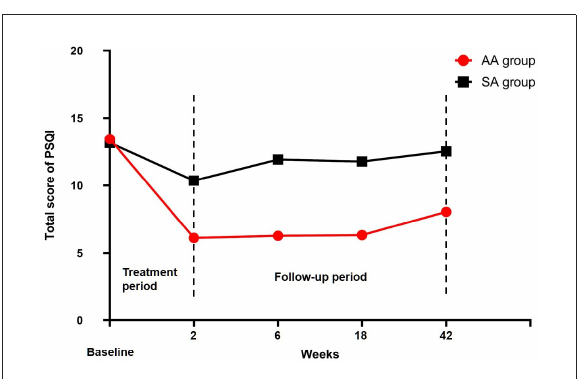
FIGURE5 Total PSQI scores were compared between the two